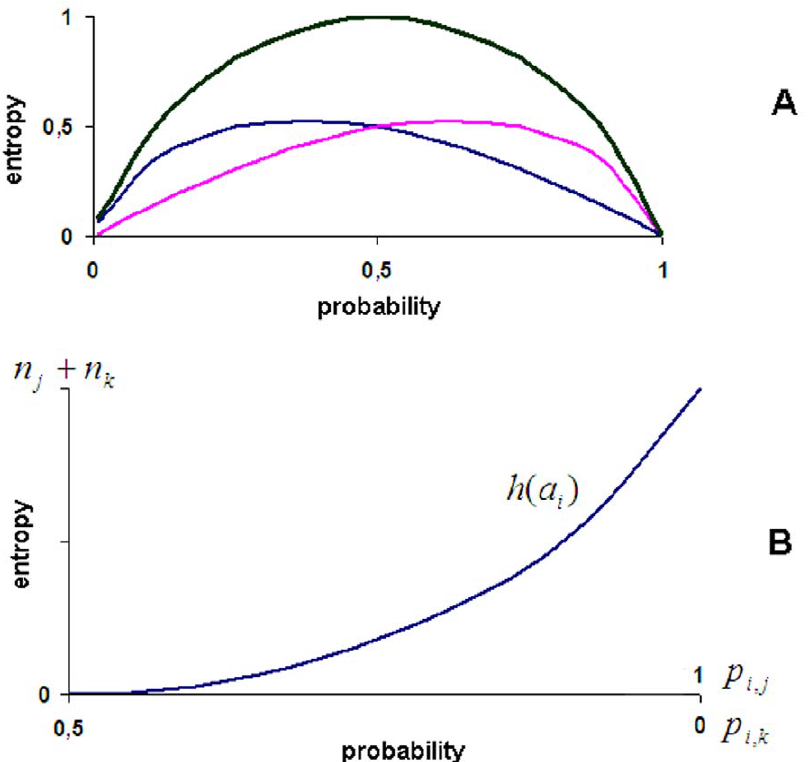
Figure 8. The message exchange entropies h ( c i , j ) for agent a i (A) and the entropy h ( a i ) of the recruitment of the agent a i in the solution of a task t (B). See text for further